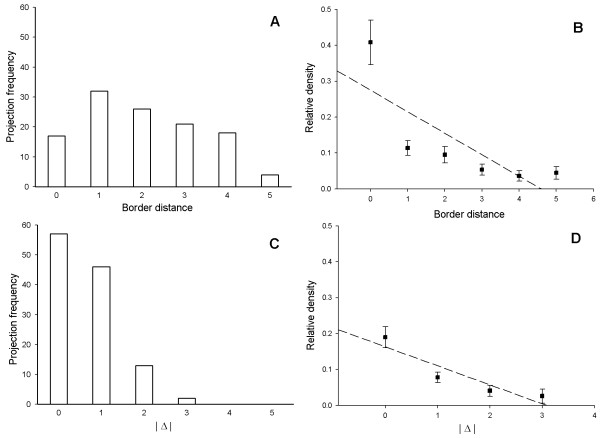
Comparison of border distance and structural type (Δ) as determinants of the pattern of contralateral projections. (A) Frequency of contralateral projections depending on border distance, defined as the number of borders between the contralateral area of projection origin and the area homotopic to the injection site. (B) The relationship of the density of contralateral projections to border distance (Spearman's ρ = -0.87; p (two-tailed) < 0.0002). (C) Frequency of contralateral projections as a function of the absolute structural type difference of the linked areas, delta (|Δ|). (D) The relationship of the density of contralateral projections to the type similarity between the contralateral area of origin and the ipsilateral target area, |Δ| (Spearman's ρ = -0.96; p (two-tailed) < 0.0005). Note that in panels A and C data were pooled over adjacent intervals to avoid artificial variance from sparsely filled categories. In these cases, a distance or Δ of '2', for instance, included data for distance or Δ for 2 proper as well as for 2.5.